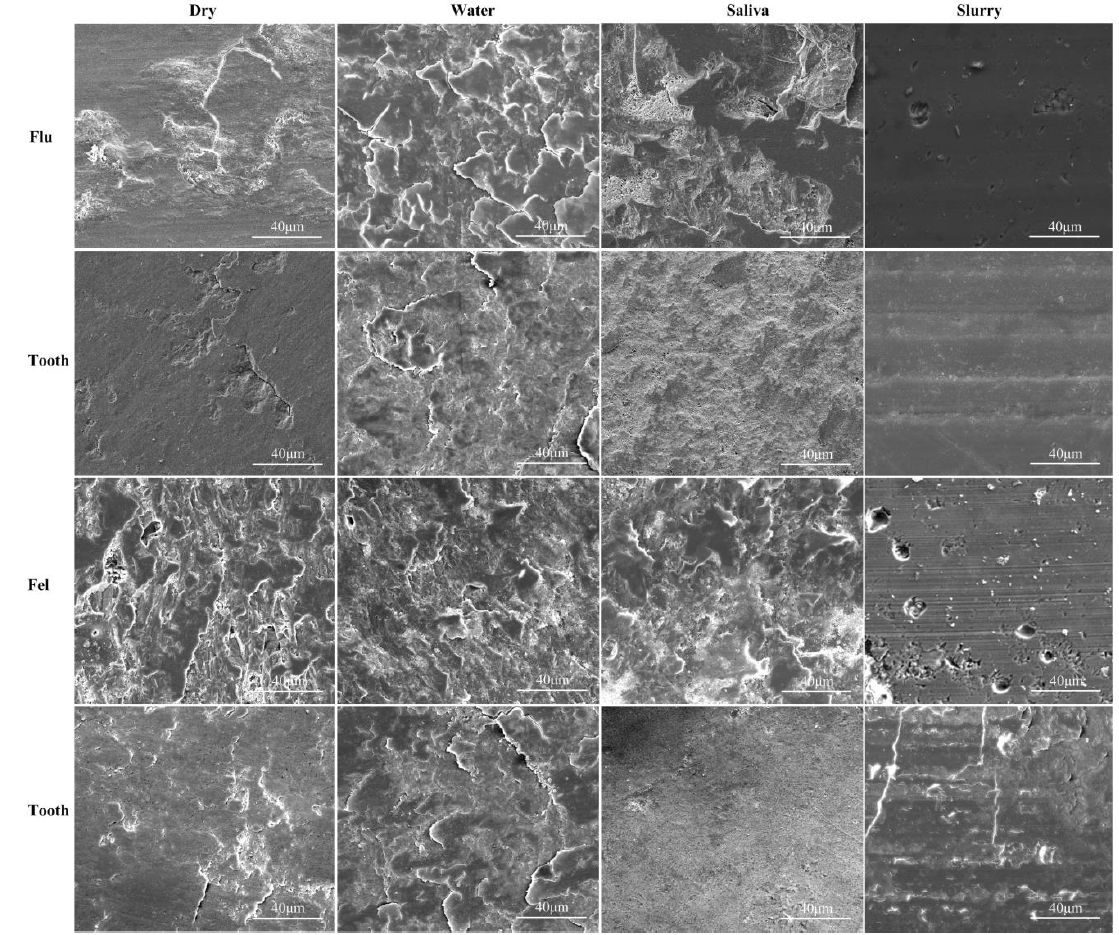
Figure 4. Wear morphology of the fluorapatite glass-ceramics (the first row) with their opposing teeth (the second row) and feldspathic glass-ceramics (the third row) with their opposing teeth in dry, water, saliva, and slurry conditions (the first column to the fourth column, respectively).